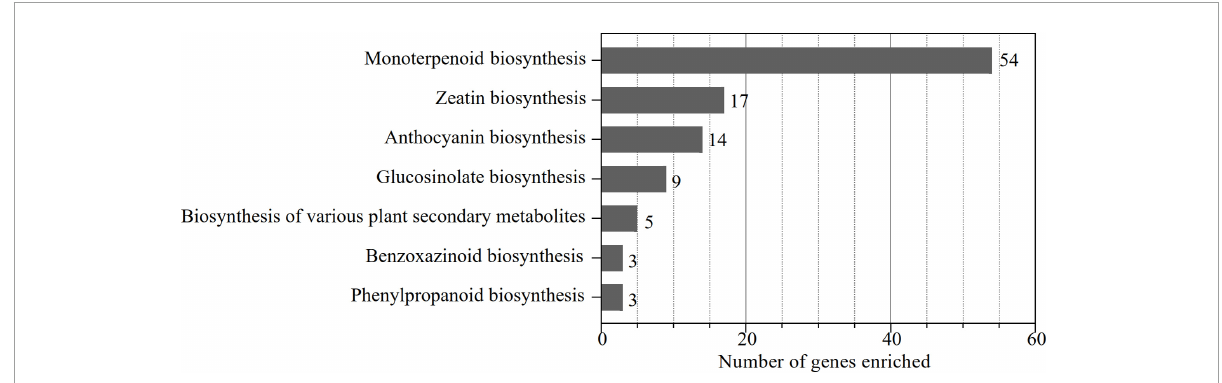
FIGURE1 Number of UGT genes involved in secondary metabolism-related pathways. The KO identifiers (called K numbers) we considered associated with the secondary metabolism network are displayed: monoterpenoid biosynthesis (K21373, K21374), zeatin biosynthesis (K13493, K13494, K13495, K13496), anthocyanin biosynthesis (K12930, K12938, K17193), glucosinolate biosynthesis (K11280), biosynthesis of various plant secondary metabolites (K21371), phenylpropanoid biosynthesis (K12356), and benzoxazinoid biosynthesis (K13227).